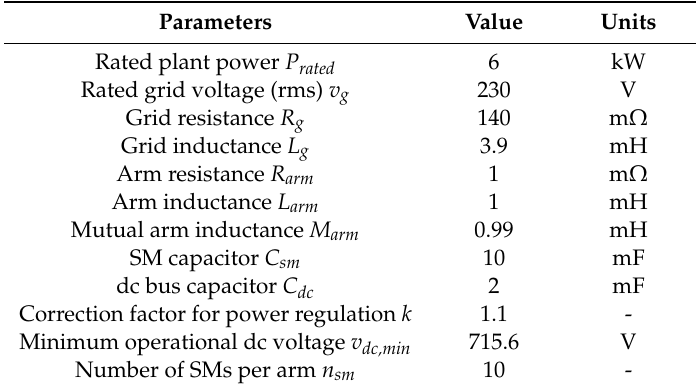
Table 1. Main MMC-PV system